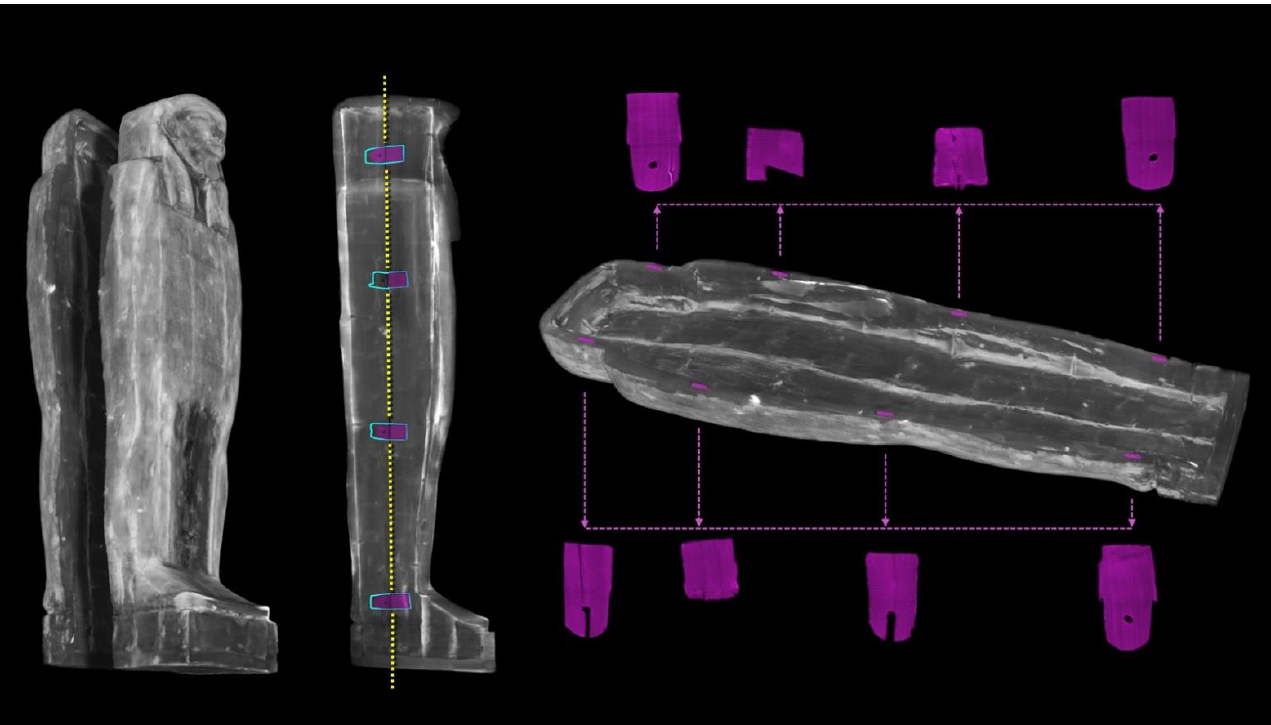
Figure 14. The 3D rendering of the opened coffin (left) and analysis of its closing system with the eight tenons virtually extracted (in purple).